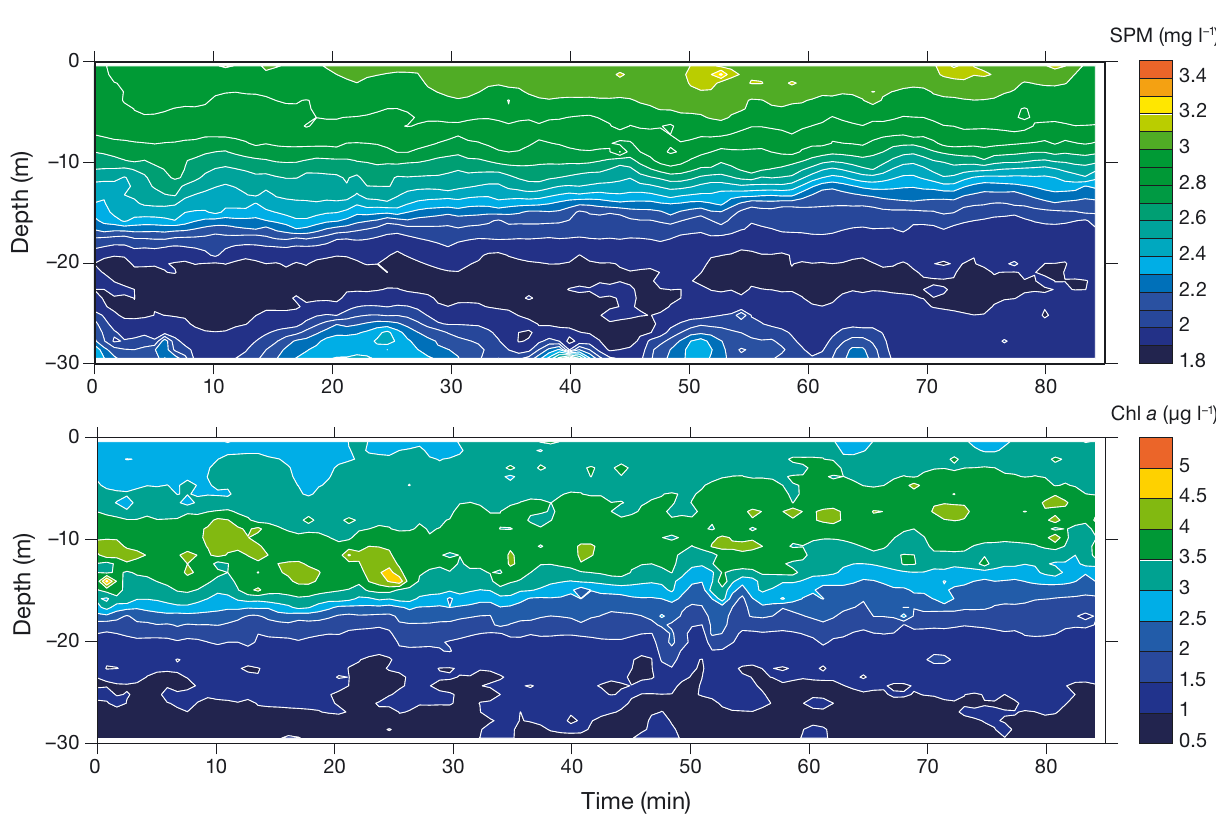
Fig. 7. Time-series contour plots of total suspended particulate matter (SPM) and chlorophyll a (chl a ) concentrations in the water column at 2 m distance from a salmon net-pen on the outflow side of the Rataran farm (Fig. 1). The plots are based on in situ sensor profiles from 0.5 to 30 m depth, conducted at 3 min intervals, starting at 13:38 h on 6 August 2014